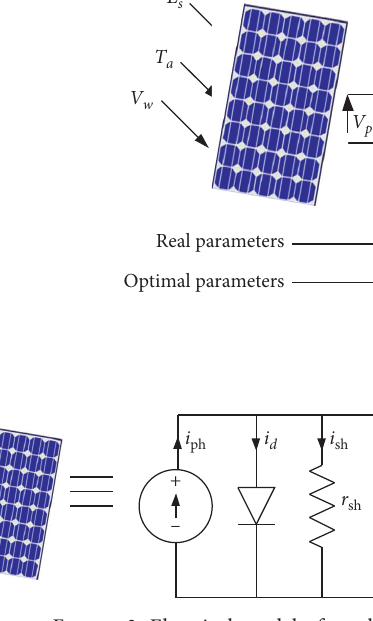
Figure 3: Electrical model of a solar